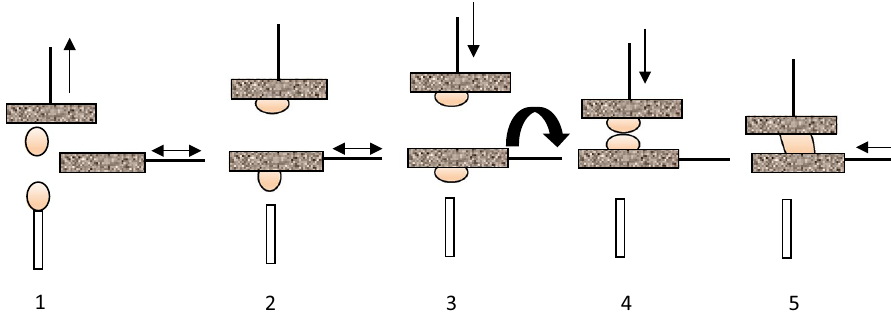
Fig. 4 Schematic diagram of the dual-drop dual-crystal